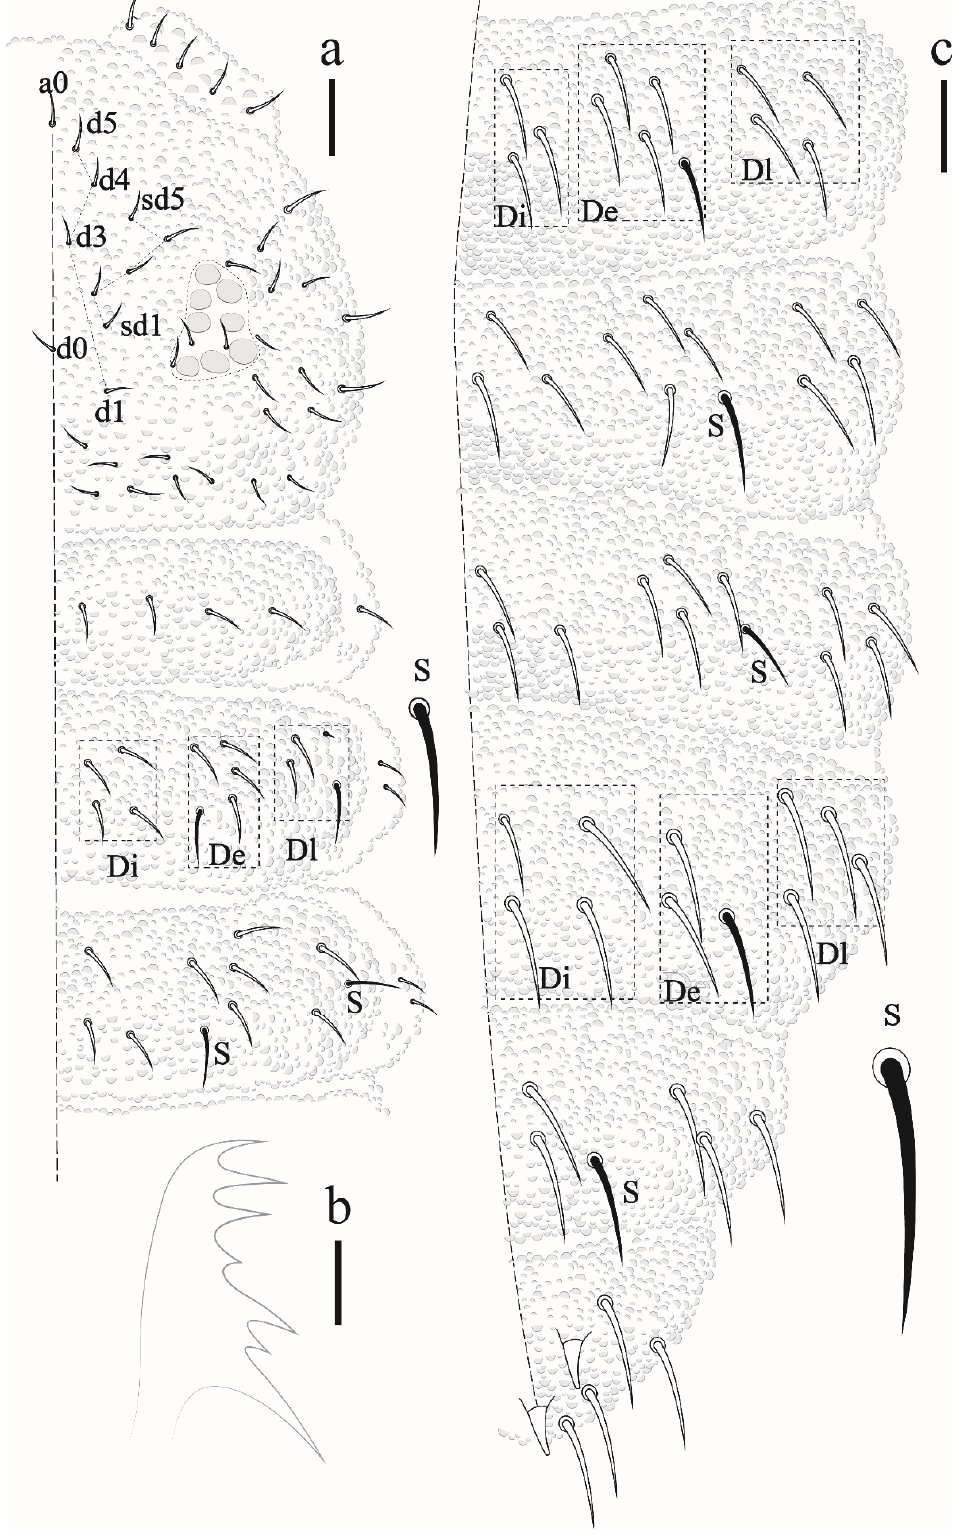
Figure 8. Friesea rochedoensis sp. nov. ( a ) dorsal view of head and Th I–III, scale bar: 20 µm. ( b ) mandible, scale bar: 20 µm. ( c ) dorsal view of abdominal segments I–VI, scale bar: 20 µm.